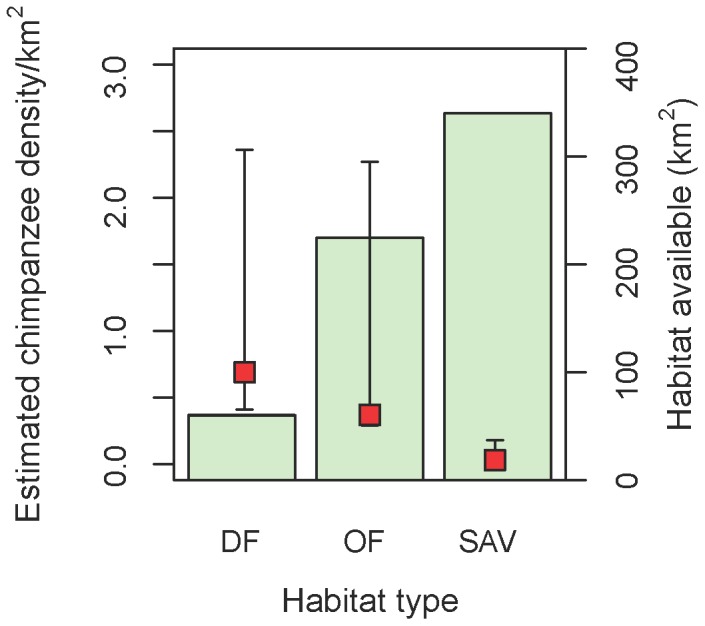
Estimates of chimpanzee density by habitat type for 2011.Estimates were based on line transect surveys, applying the Standing-Crop Nest Counts method. Also indicated is the area occupied by each type of habitat in Lagoas de Cufada Natural Park. Dense canopy forests (DF), open canopy forests (OF) and savannah-woodlands (Sav) were the habitats considered.